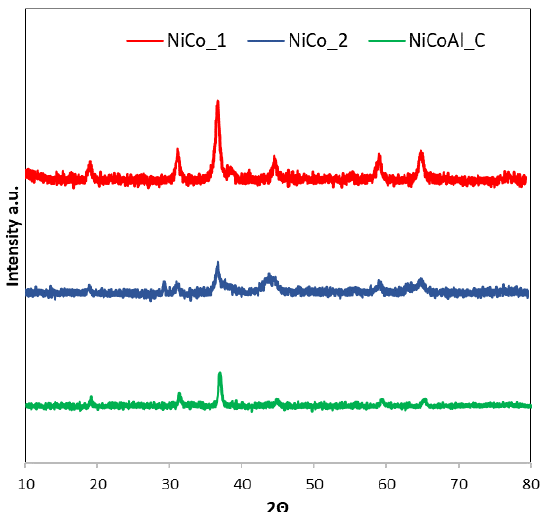
Figure 6. XRD patterns of NiCo_1, NiCo_2, NiCoAl_C samples.